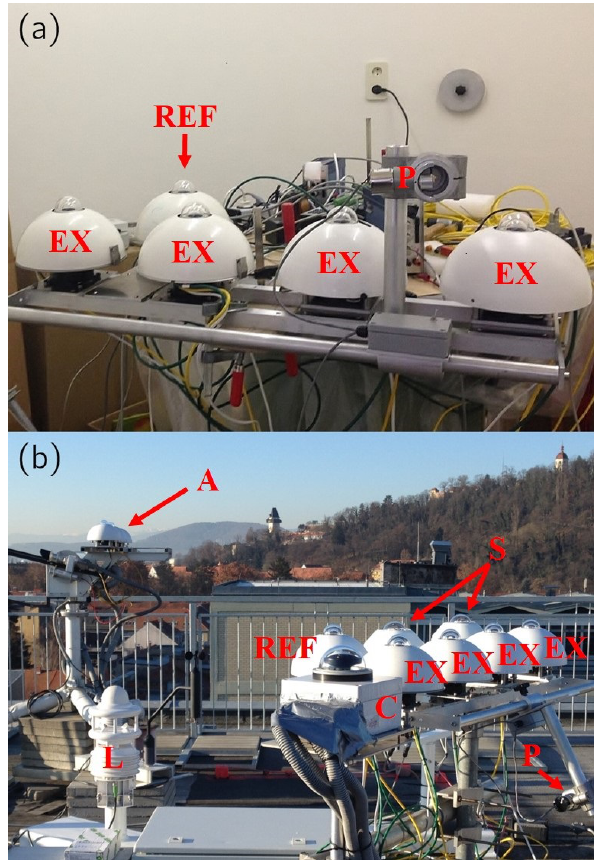
Figure 2. Measurement setup at (a) the Kanzelhöhe Observatory and (b) the measurement platform of Graz University in the direct vicinity of the ARAD site. During the field campaigns the mea- surement setup was expanded by an “all-in-one” meteorological ob- serving system for the monitoring of ambient meteorological con- ditions, two star pyranometers, and a cloudcam. The labels are de- fined as follows: REF is the reference CMP21 pyranometer con- tained in an Eigenbrodt SBL 480 HV-system; EX are the “experi- mental” CMP21 pyranometers contained in an Eigenbrodt SBL 480 HV-system, a Davos (PMOD/WRC) HV-system, a self-built KSO34 HV-system, and another self-built KSO HV-system; P is the elec- tric motor pump used for the automated spray tests; L is the all-in- one meteorological observing system (WS600-UMB manufactured by Lufft GmbH); C is the cloudcam (VIS-J1006, manufactured by CMS Schreder GmbH); S are two star pyranometers (type 8102, manufactured by Schenk); and A is the Graz University ARAD